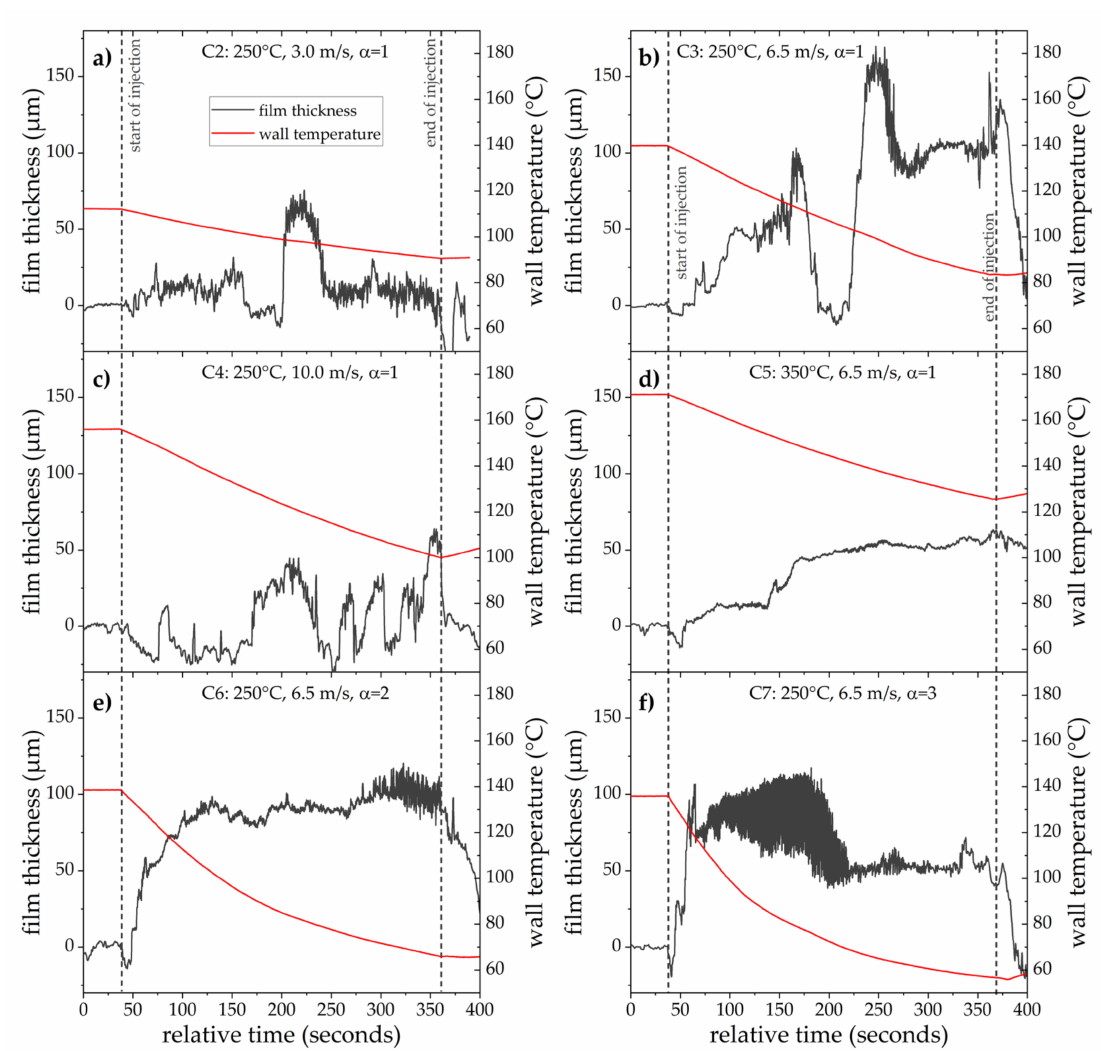
Figure 8. Film thickness measurements (black) of AdBlue and wall temperature (red) measured at the same location 0.3 mm below the surface. The dashed vertical lines marked the beginning and end of AdBlue injection. Measurements were performed at operation points listed as follows: ( a ) 250 ◦ C, 3 m , α = 1; ( b ) 250 ◦ C, 6.5 m , α = 1; ( c ) 250 ◦ C, 10 m , α = 1; s s s ( d ) 350 ◦ C, 6.5 m , α = 1; ( e ) 250 ◦ C, 6.5 m , α = 2; ( f ) 250 ◦ C, 6.5 m , α = s s s